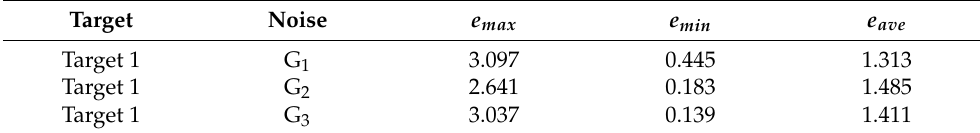
Table 7. Comparison of positioning errors with non-Gaussian